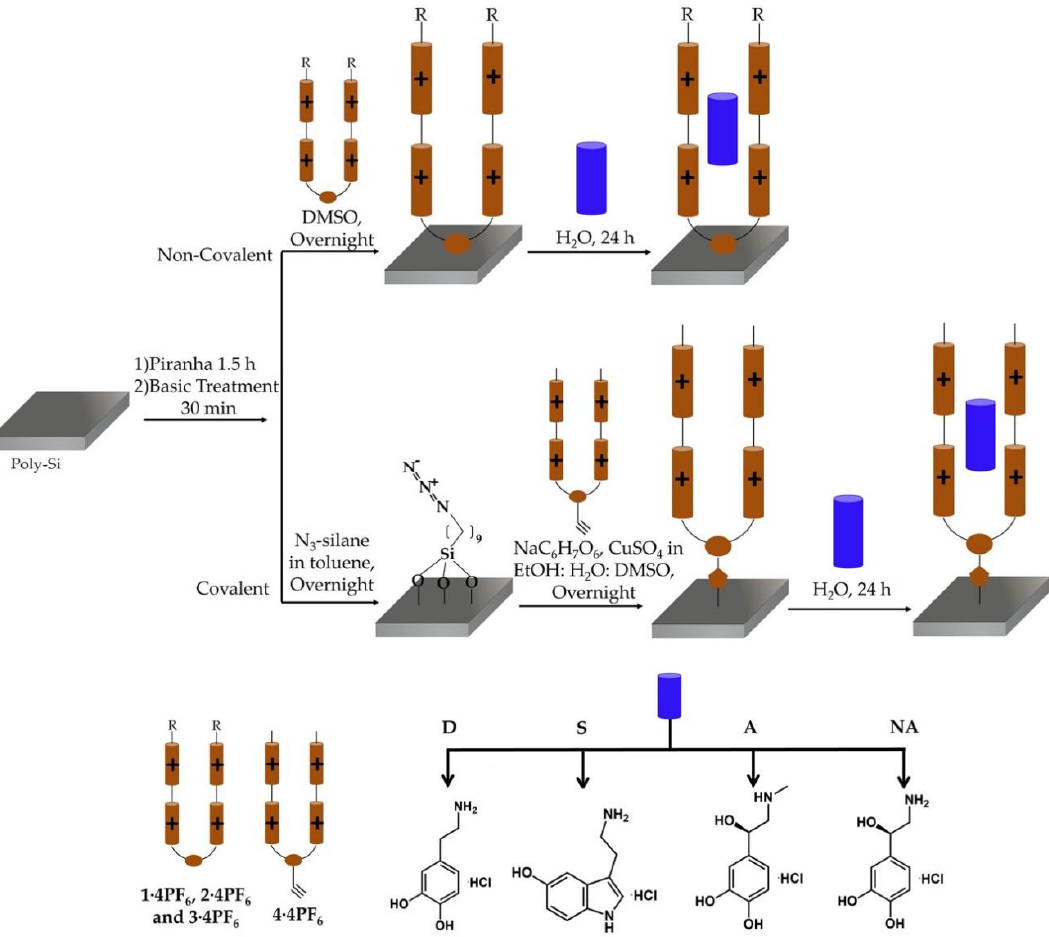
Scheme 2. Functionalization of polysilicon surfaces (Poly-Surfs) and microparticles (Poly-Si μ Ps) with bipyridinium salts 1 · 4PF 6 – 4 · 4PF 6 and the subsequent incorporation of D , S , A or NA . R = CH 3 ( 1·4PF 6 );